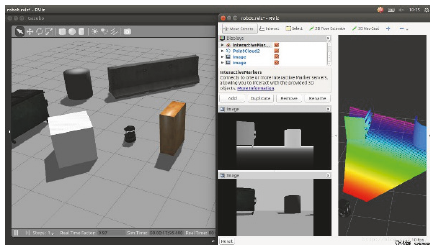
Figure 8: Virtual test of robot